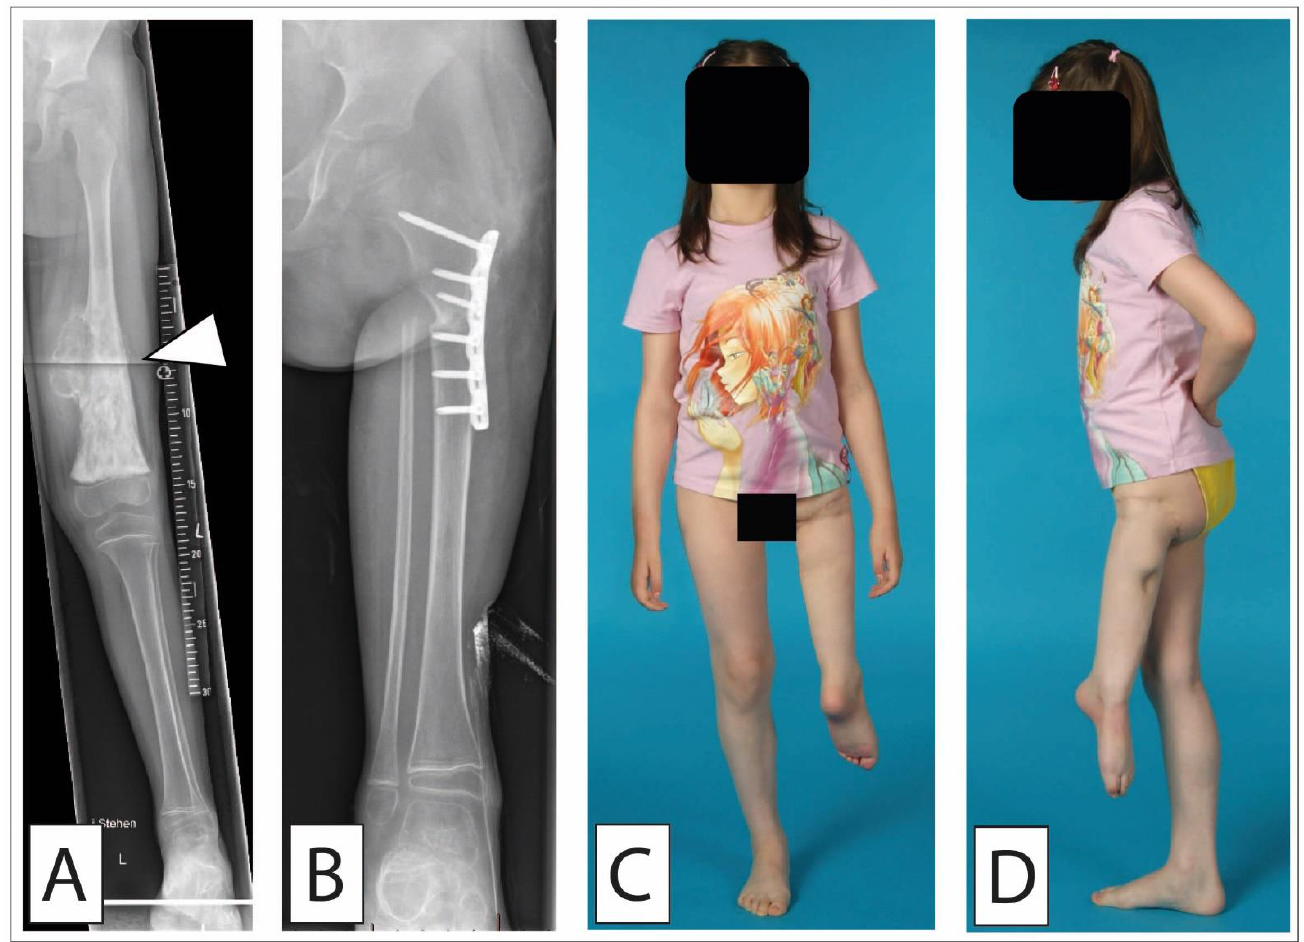
Figure 1. Osteosarcoma of the distal femur treated with rotationplasty. A 5-year-old girl presenting with pain in the left thigh. ( A ) The plain a-p radiograph showed an osseous tumor (white arrow) of the distal left femur highly suggestive for osteosarcoma. Histopathologic analyses after open biopsy confirmed high-grade osteosarcoma. In MR imaging, it could be determined that it was located near vessels and nerves, respecting the epiphyseal plate. Due to the young age and the suitable location, we performed rotationplasty according to the technique of van Nes. Different techniques of rotationplasty have been proposed depending on the location of the tumor in the femur [47] . ( B ) Antero-posterior radiograph showing the osteosynthesis by means of an LCP plate in the subtrochanteric region. Clinical frontal ( C ) and lateral ( D ) image after wound healing.